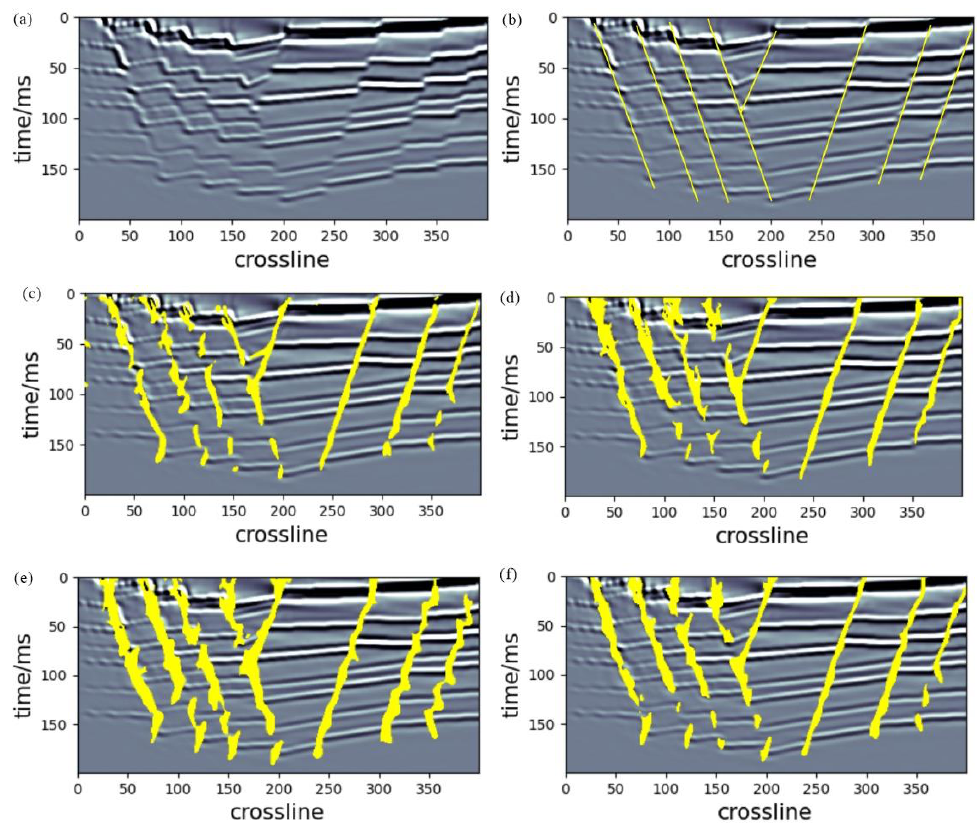
Figure 6. Model accuracy change curves: ( a ) batch size = 1; ( b ) batch size = 3; ( c ) batch size = 5; ( d ) batch size = 6.